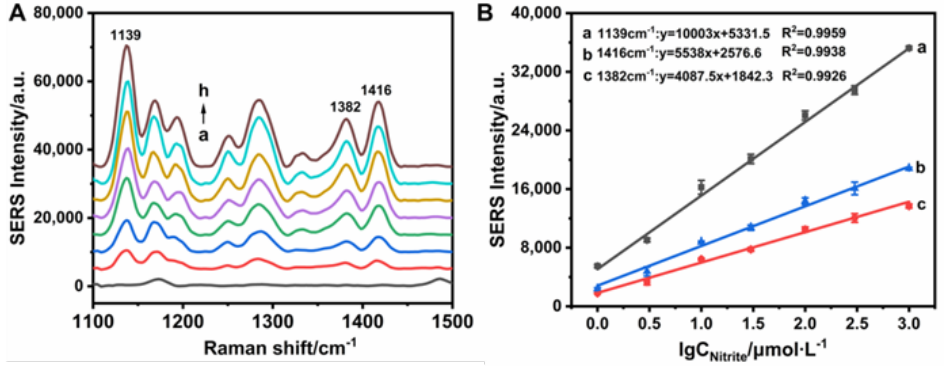
Figure 5. ( A ) SERS spectra of different concentrations of nitrite: (a) 0, (b) 1.0 × 10 − 6 , (c) 3.0 × 10 − 6 , (d) 1.0 × 10 − 5 , (e) 3.0 × 10 − 5 , (f) 1.0 × 10 − 4 , (g) 3.0 × 10 − 4 , (h) 1.0 × 10 − 3 mol L − 1 ; ( B ) the correlation between SERS intensity and logarithmic value of the nitrite concentration at the bands of 1139, 1382, and 1416 cm − 1 on AuNP/ITO chip. Table 1. Comparison of the developed SERS method with the reported literatures for the detection of nitrite.